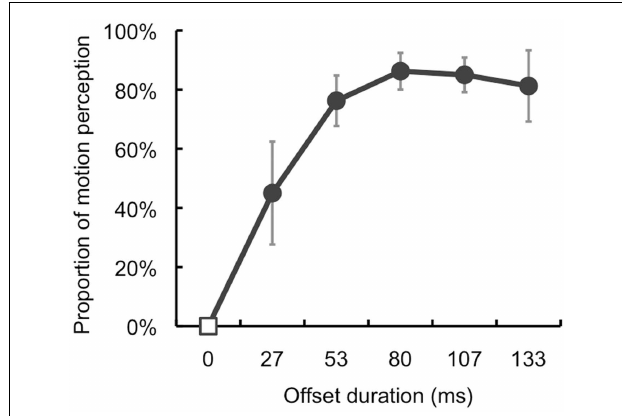
FIGURE 3 | Results of Section “Experiment 2.” The proportion of illusory motion perception increased with longer offset duration. Error bars denote standard errors of the mean ( N =